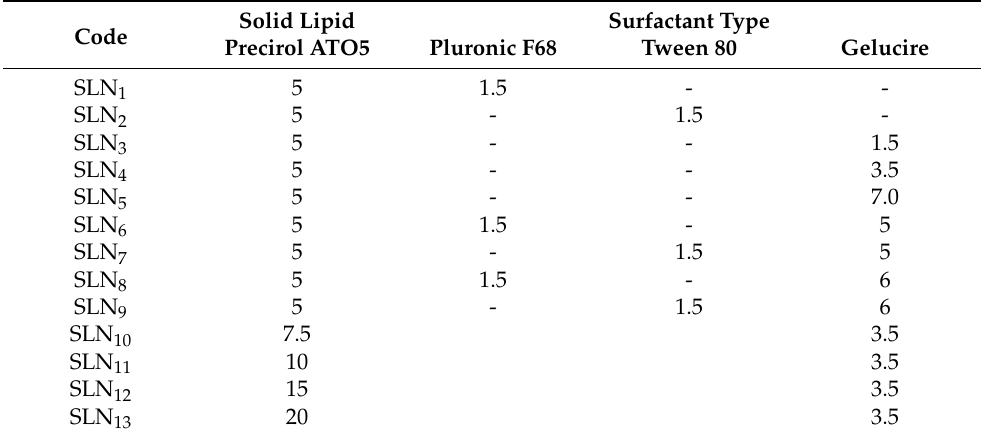
Table 2. Composition (% w / w ) of the different SLN colloidal dispersions in water. Code